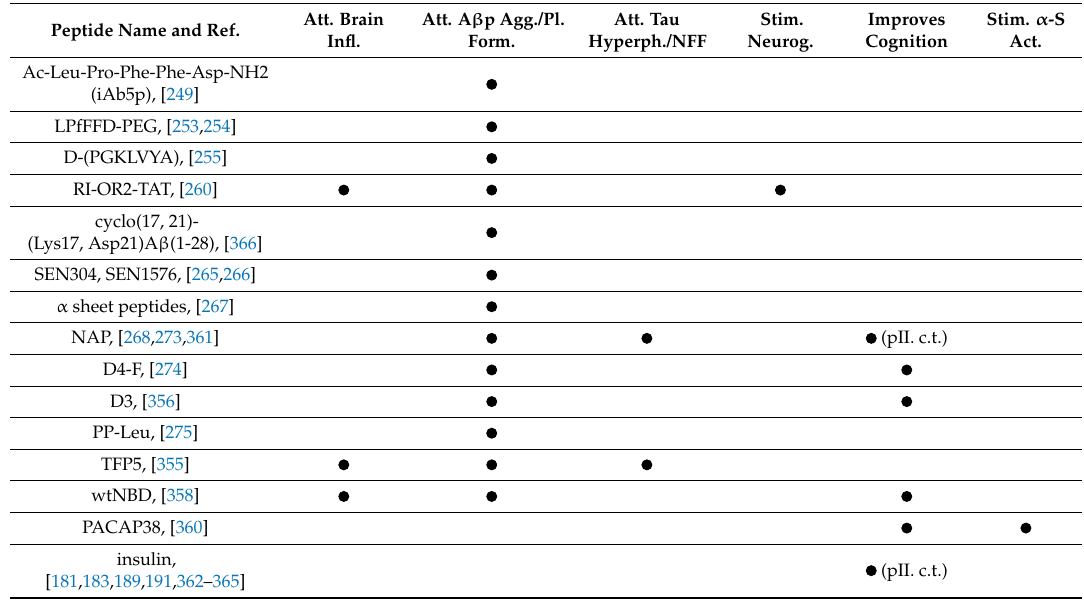
Table 1. AD modifying peptides with brief description. Abbreviations: act. (activity); agg. (aggregation); att. (attenuates); hyperph. (hyperphosphorylation); infl. (inflammation); NFF (neurofilament formation); pII. c.t. (phase II clinical trials); pl. form. (plaque formation); ref. (reference); stim. (stimulates); α -S ( α -secretase); (observed effect). Att. Brain Peptide Name and Ref.